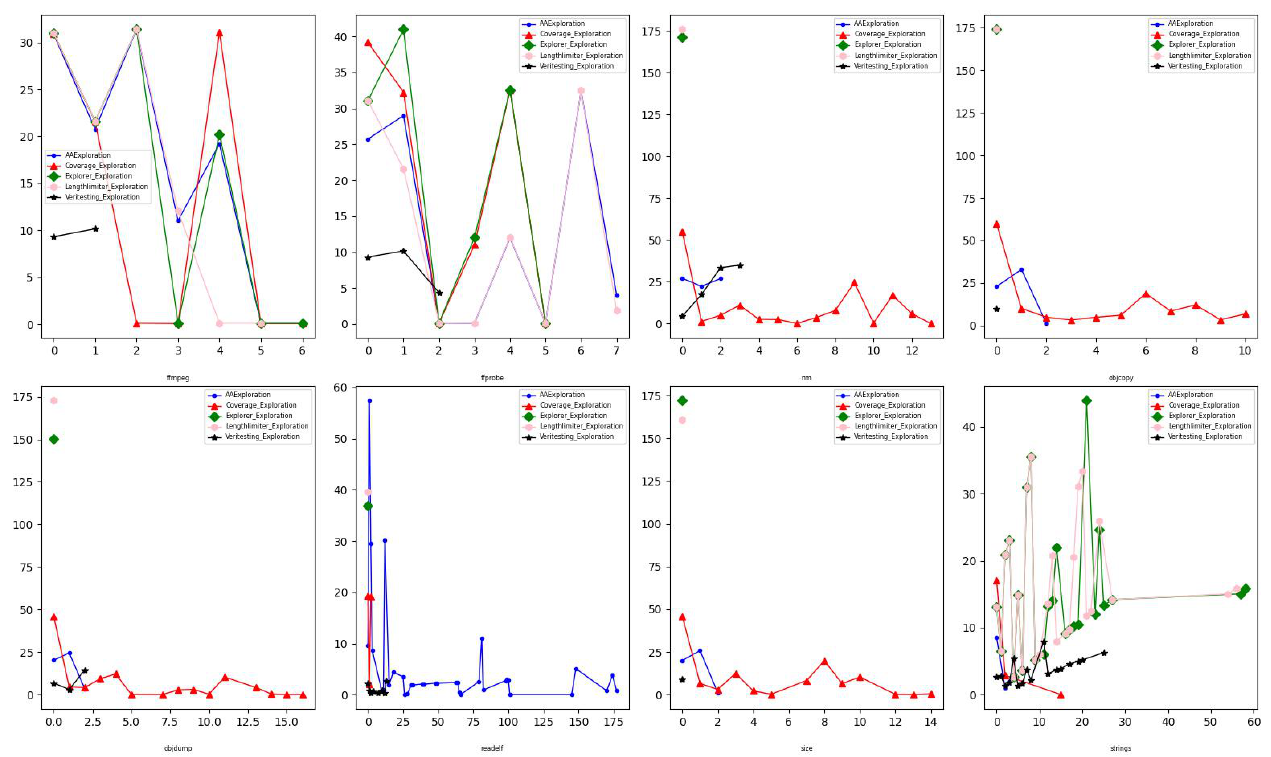
Figure 3. Performance overhead when exploring programs that do not cause state space